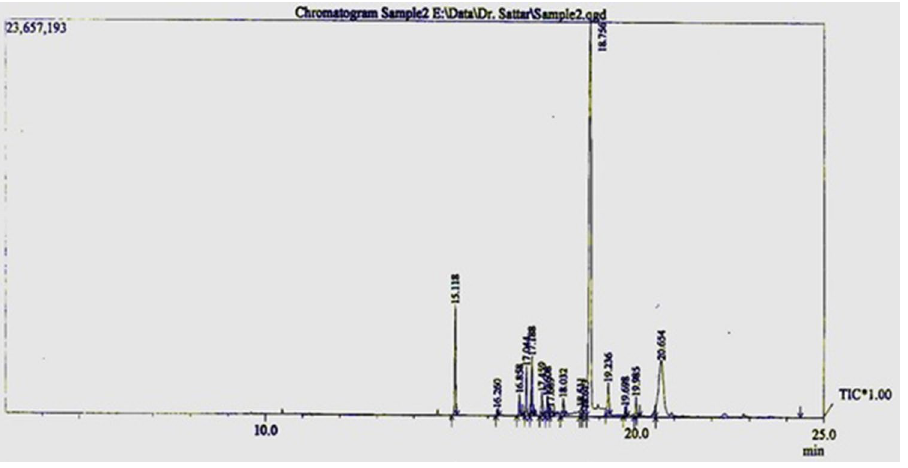
Figure 1. GC–MS chromatogram of